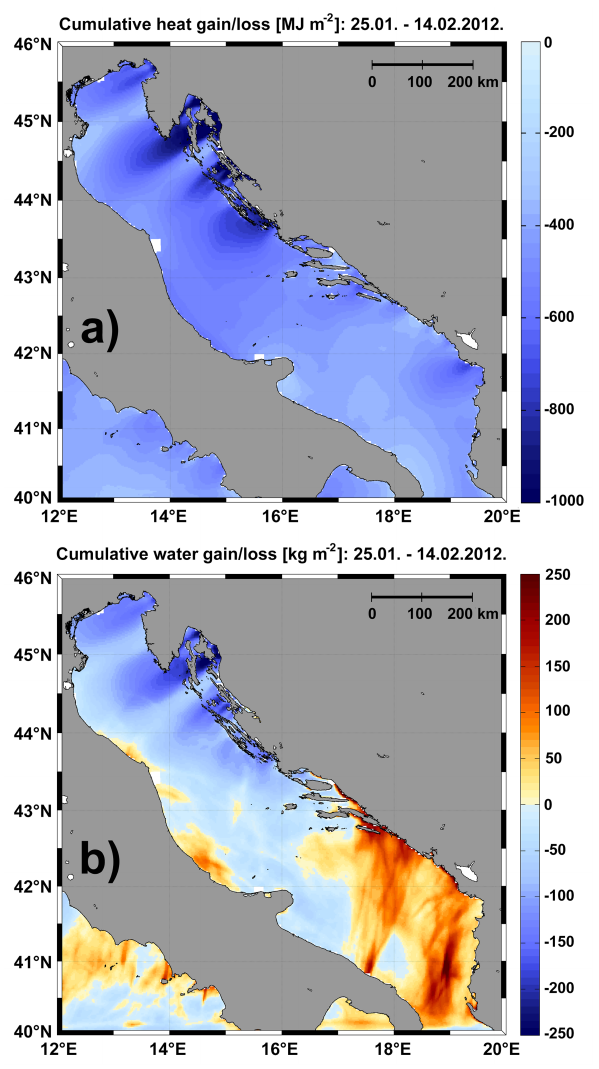
Fig. 5. Cumulative (a) heat and (b) water gain/loss between 25 Jan- uary and 14 February 2012 as estimated by the ALADIN/HR model. Negative values denote heat and water losses from the